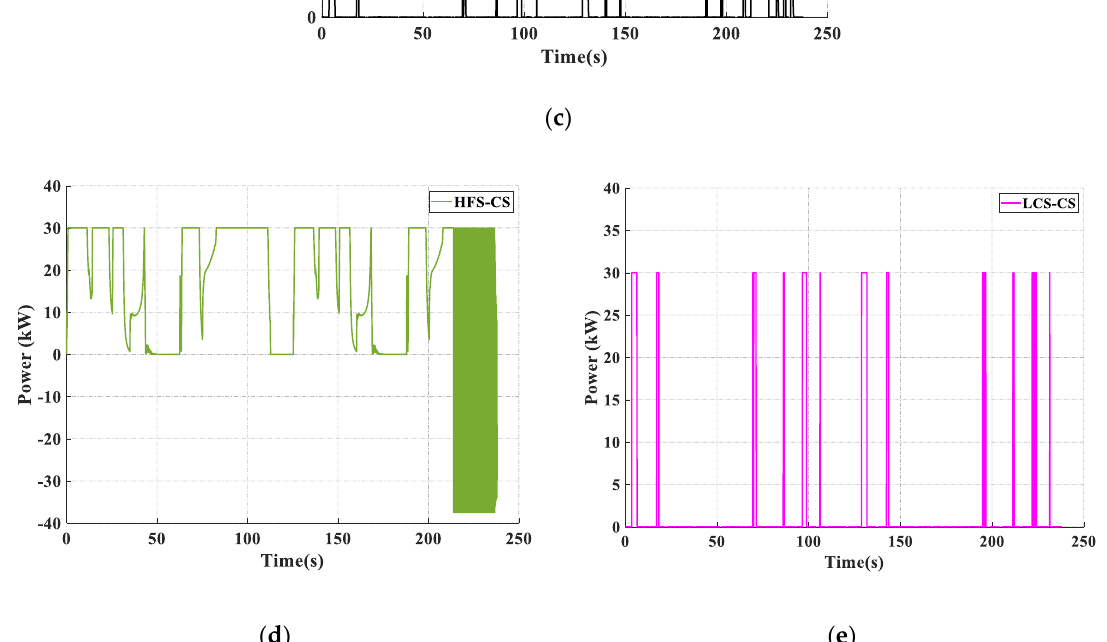
Figure 14. Power released from the BAT for the five strategies: ( a ) proposed F–EMS, ( b ) proposed EMS, ( c ) conventional EMS (C–EMS), ( d ) HFS–CS, and ( e ) LCS–CS.